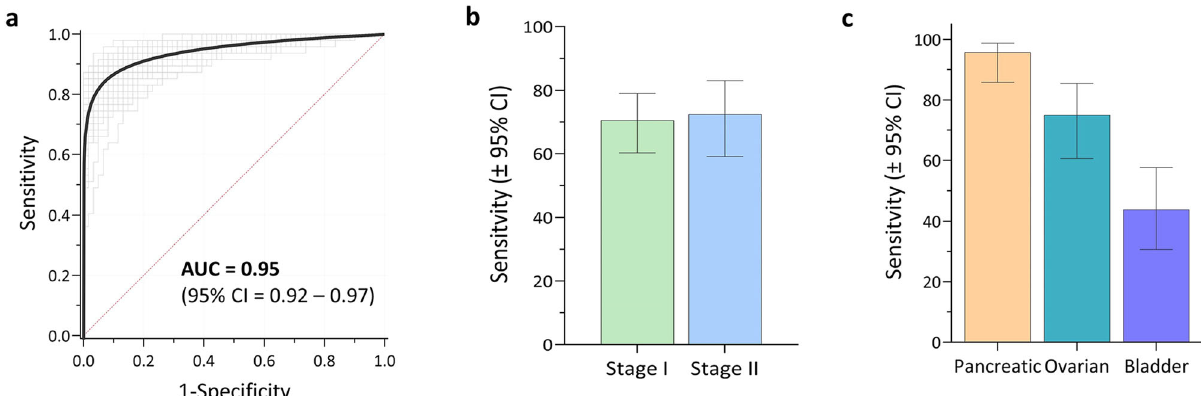
Fig. 4 Overall performance for detecting the presence of early cancer using an EV protein-based logistic classi fi er. a ROC curves from comparison of the cancer cases ( N = 139) to the controls ( N = 184) on the held-out test sets; black line represents the averaged curve of 100 independently resampled held-out test sets (gray lines). AUC area under the ROC curve. b Sensitivities at >99% speci fi city for detecting either stage I or stage II pancreatic, ovarian, and bladder cancers combined. N for stage I cancers is 88 subjects and the N for stage II cancers is 51 subjects. c Sensitivity at >99% speci fi city for detecting either stages I and II pancreatic ( N = 47), ovarian ( N = 44), or bladder ( N = 48) cancer. Error bars in both panels ( b ), ( c ) represent the two-sided 95% Wilson con fi dence intervals.